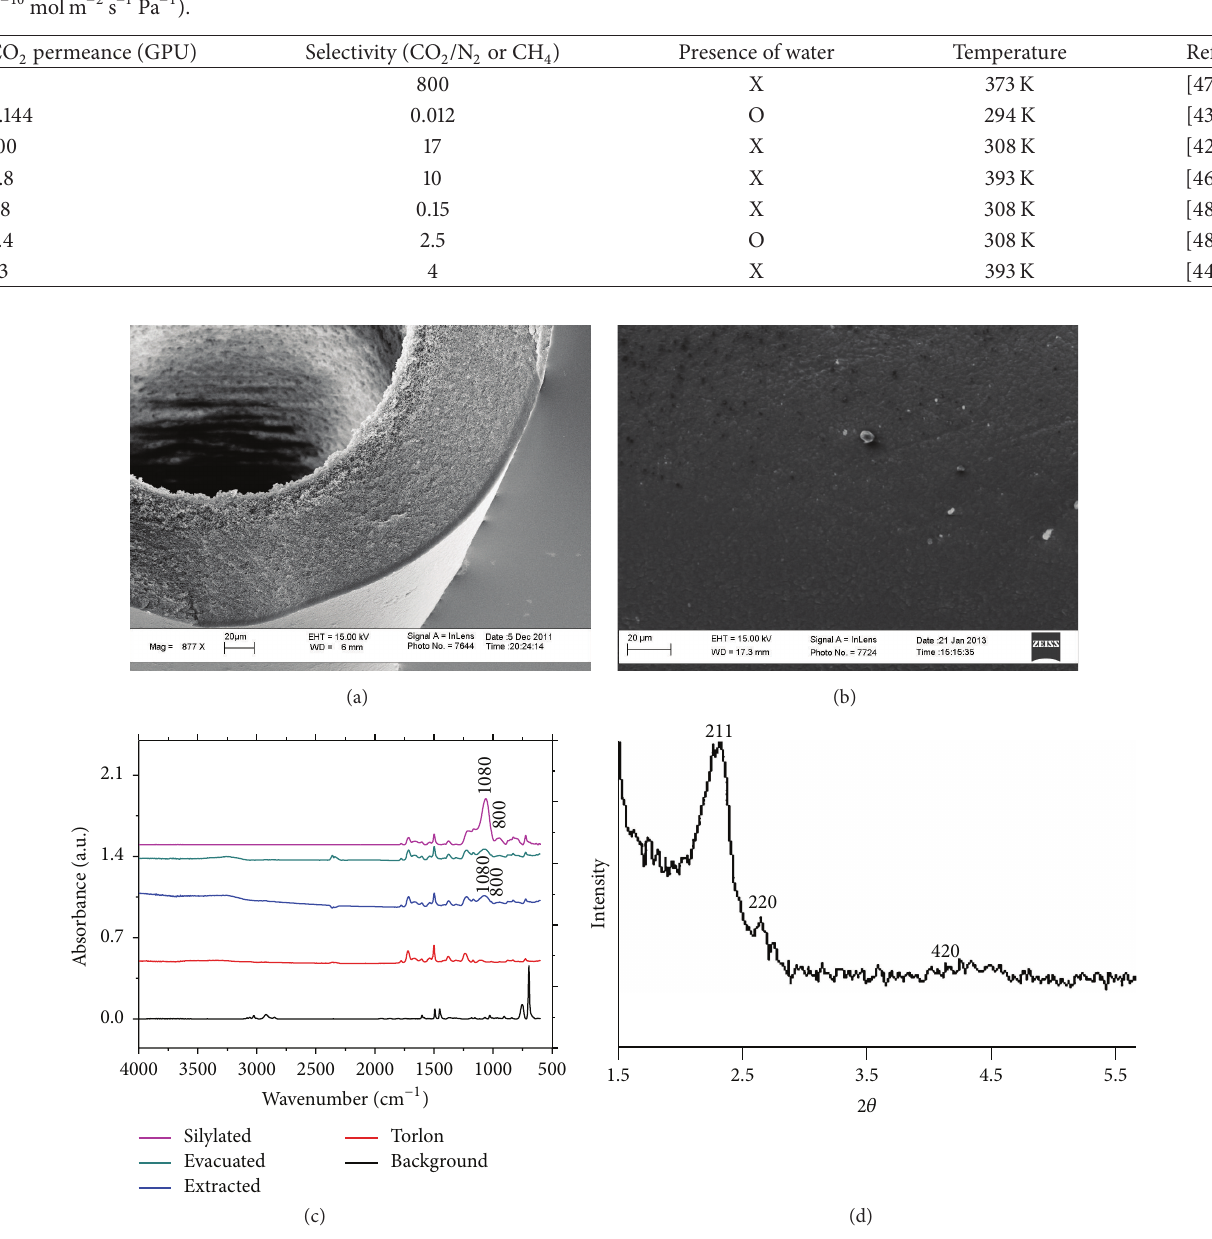
Table 2: Performance of published amine-functionalized mesoporous silica membranes for CO 2 separation (GPU = 3.35 × 10 −10 mol m −2 s −1 Pa −1 ).